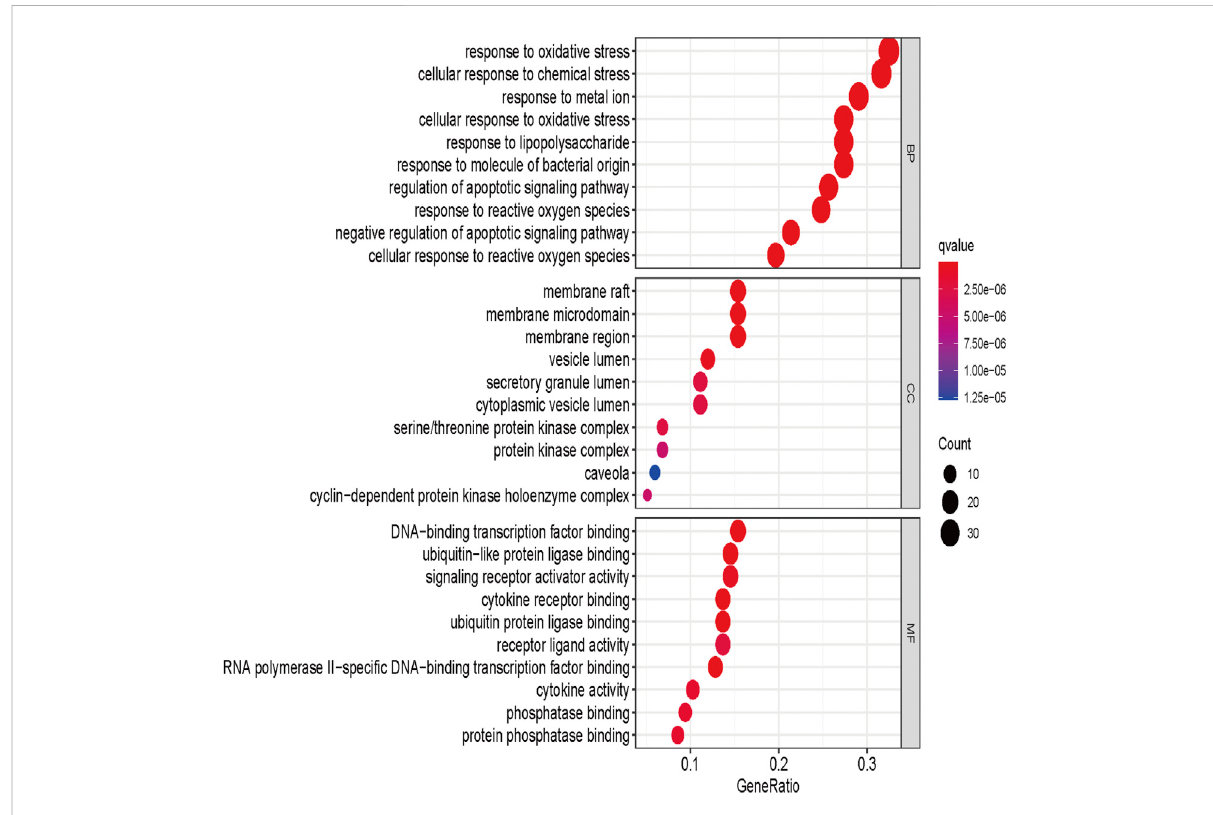
FIGURE 3 GO enrichment analysis of A. annua compound and AAA “ intersection target.